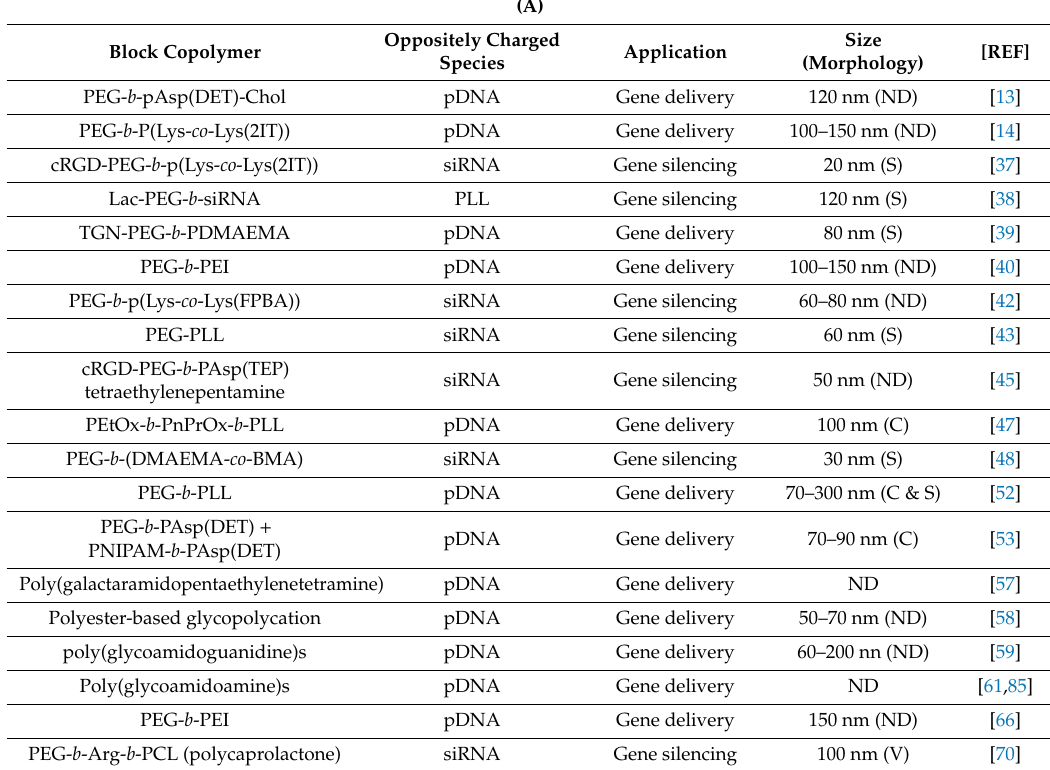
Table 1. ( A ) C3Ms with Polynucleotides. ( B ) C3Ms with Proteins. ( C ) C3Ms with (Small Molecular) Drugs and Complexes. ( D ) C3Ms with Miscellaneous Oppositely Charged Species. (Morphologies: S—sphere, E—ellipsoid, C—cylinder, V—vesicle, ND—not